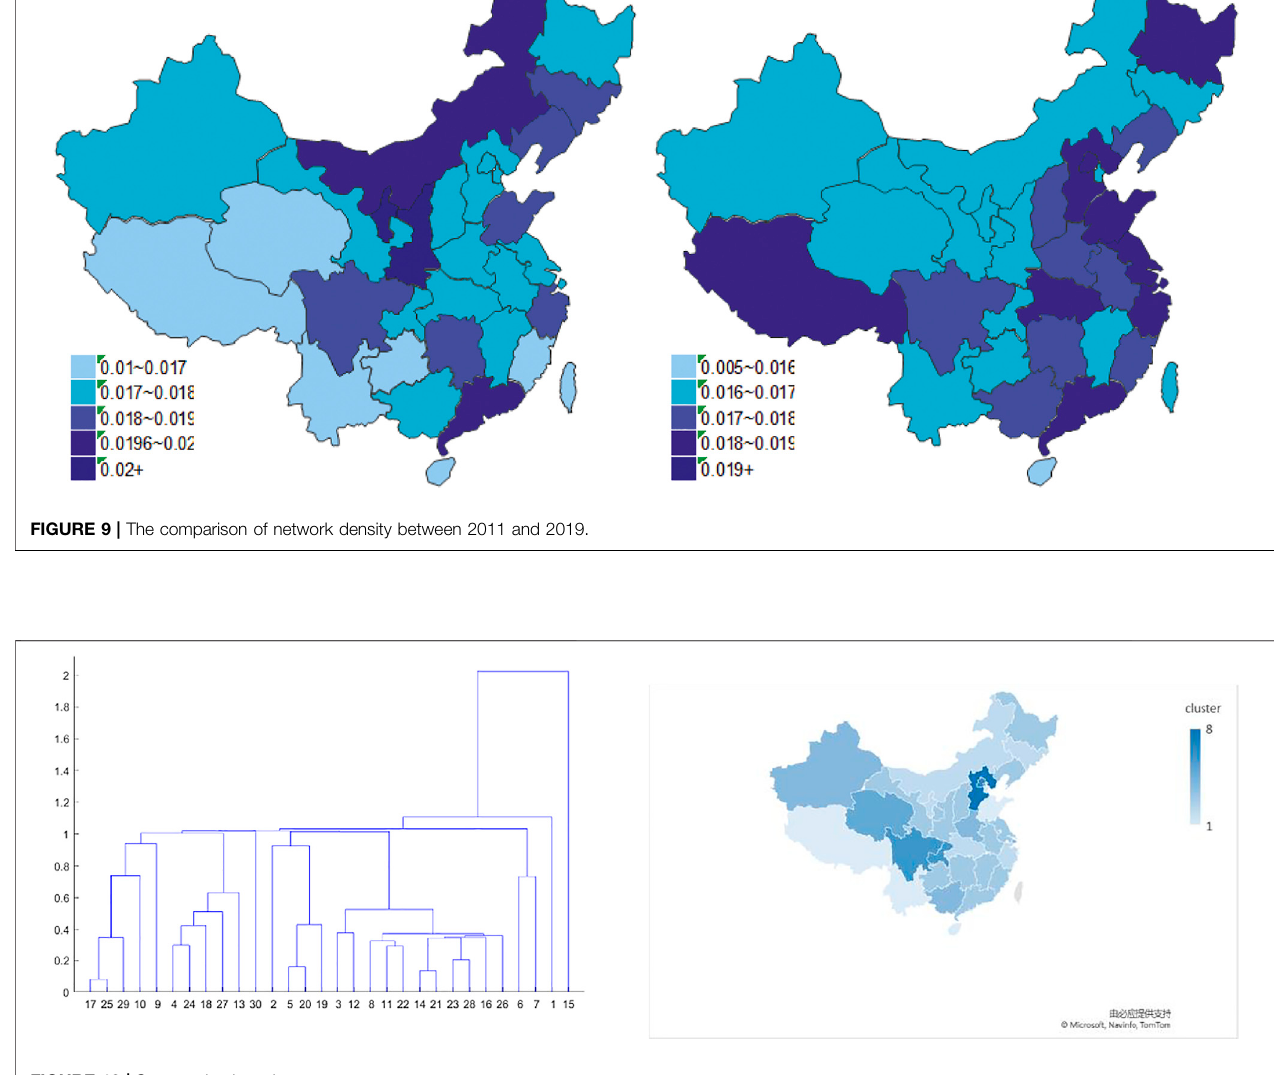
FIGURE 10 | Systematic